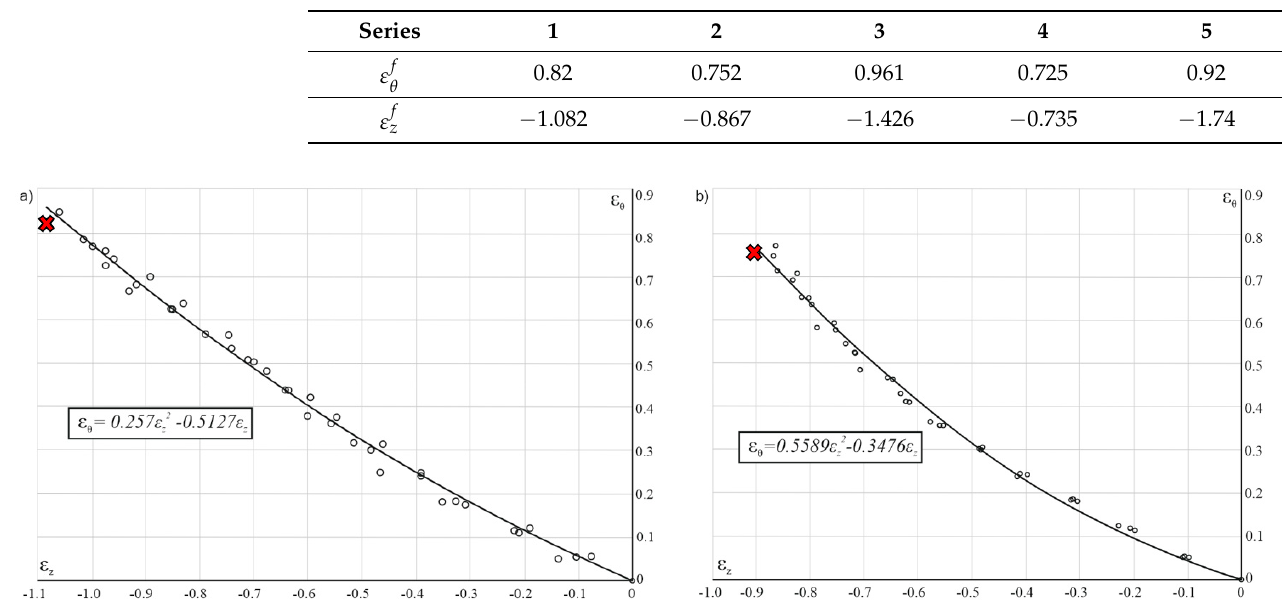
Figure 3. Typical geometric changes after each increment of the die’s displacement (Series